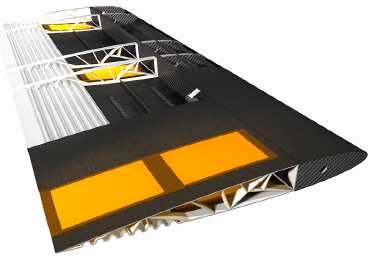
Figure 2. Example of integration of MFC patches in a wing structure [37].